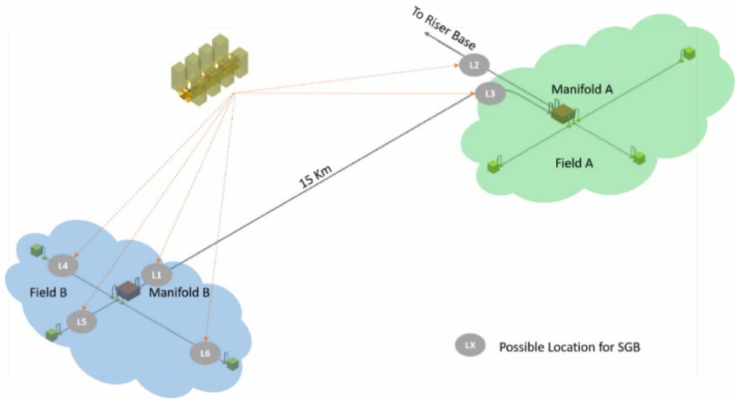
Figure 14. Oil field business